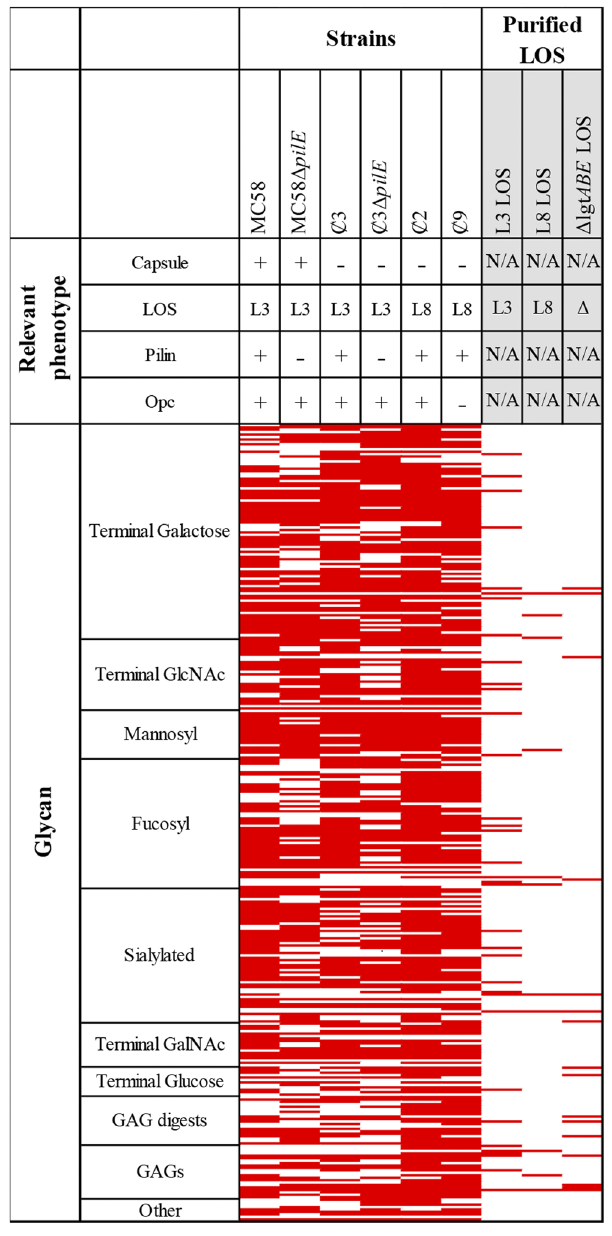
Figure 1. Heat map showing glycan binding by N. meningitidis from glycan array analysis of N. meningitidis wild-type and mutants lacking key outer membrane components. Red represents binding to the glycan structure (in three independent replicates) and white is no binding observed. Glycans are grouped based on terminating structures/ monosaccharide composition. For the full list of binding to individual glycans see Supplementary Table S1. GAG, Glycosaminoglycan; GalNAc, N -acetylgalactosamine; GlcNAc, N